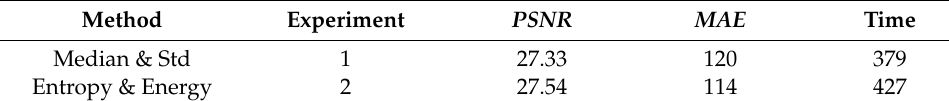
Figure 4. Impulsive Noise-Restored images with 20% density Using the TASOM classifier: ( a ) Original image; ( b ) Noisy image; ( c ) Mean; ( d ) Alpha Trimmed; ( e ) Pseudo Median; ( f ) Median. Table 9. Combination of the best features resulting from the above tables.